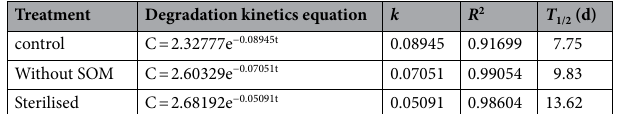
Table 9. Degradation kinetics parameters of propaquizafop in non-SOM and sterilised ginseng soils.